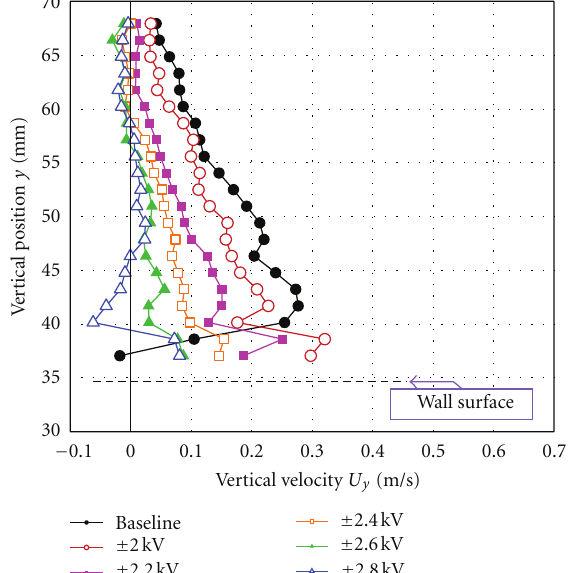
Figure 10: Vertical velocity distributions near plasma actuator ( x = 29.7mm).